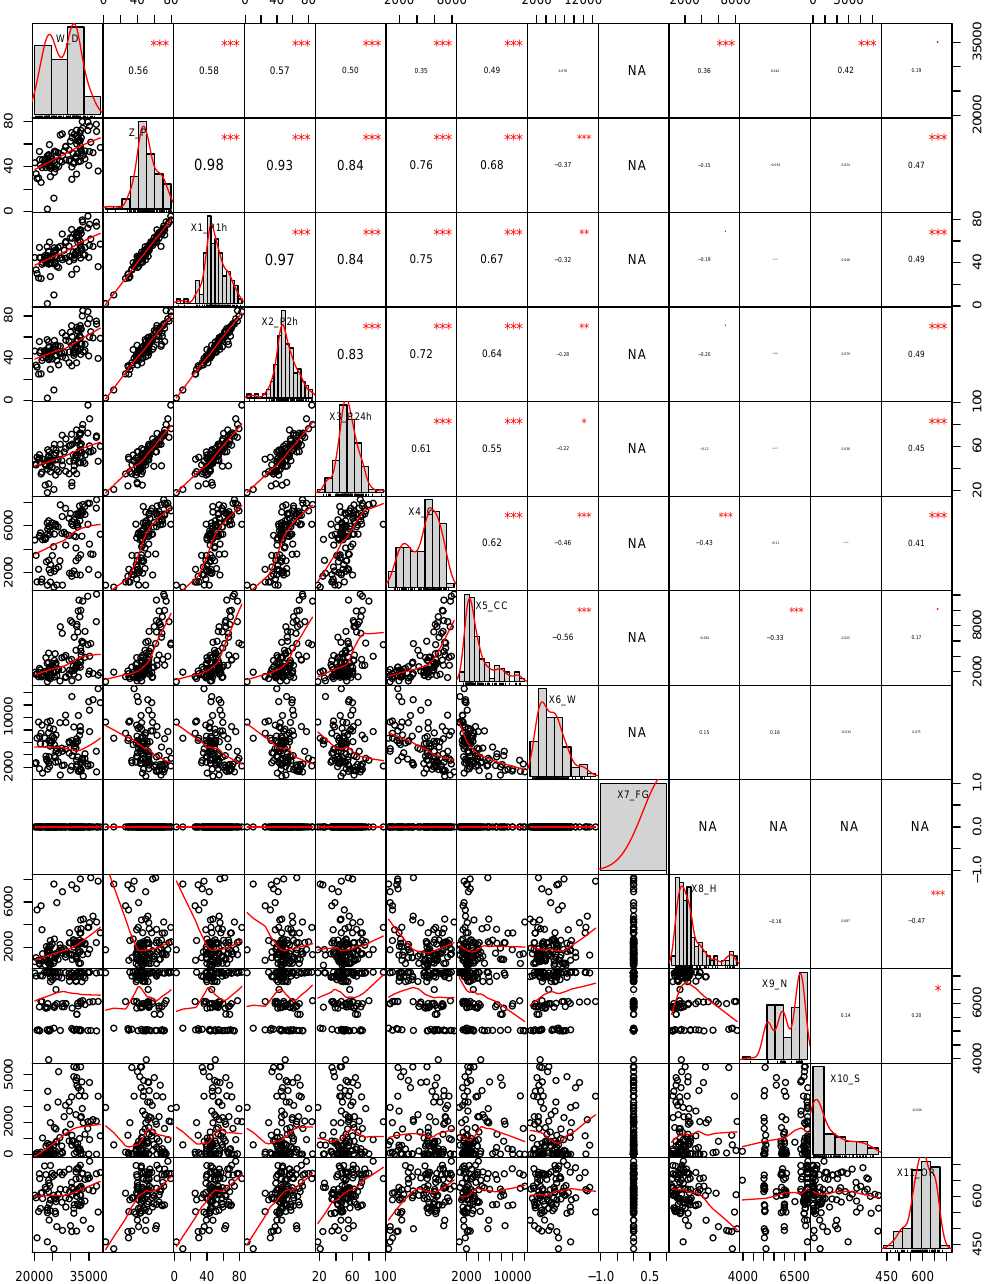
Figure 10. Correlation matrix values among all continuous input variables (diagonal: demand, price, price lagged 1 h, price lagged 2 h, price lagged 24 h, coal, combined cycle, wind, fuel–gas, hydro, nuclear, solar, other renewable). (Public source: Red Eléctrica de Espana Sistema de Información del operador del sistema,